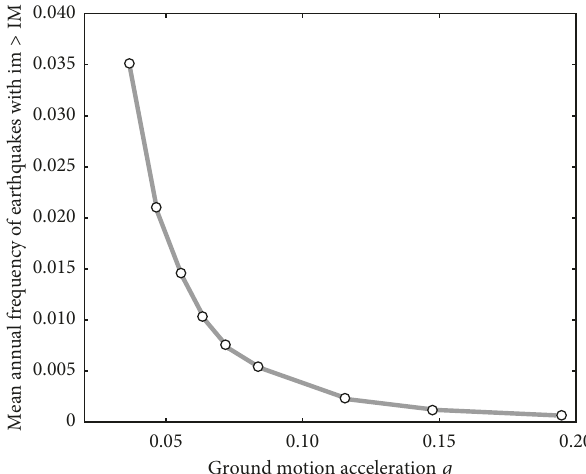
Ground motion acceleration g Figure 7: Seismic hazard curve for building no. 39 (by